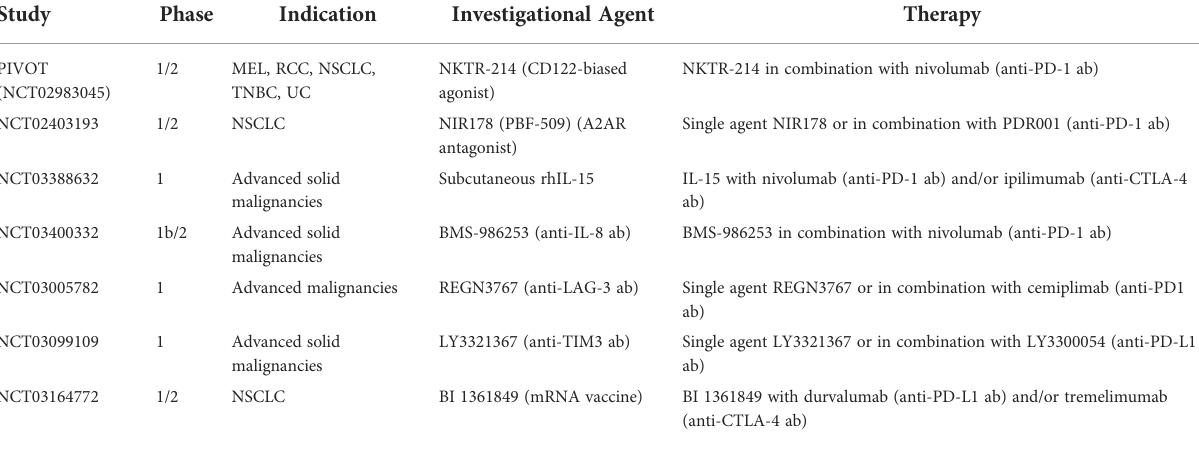
TABLE 2 Select clinical trials currently underway which utilize investigational agents in combination with checkpoint